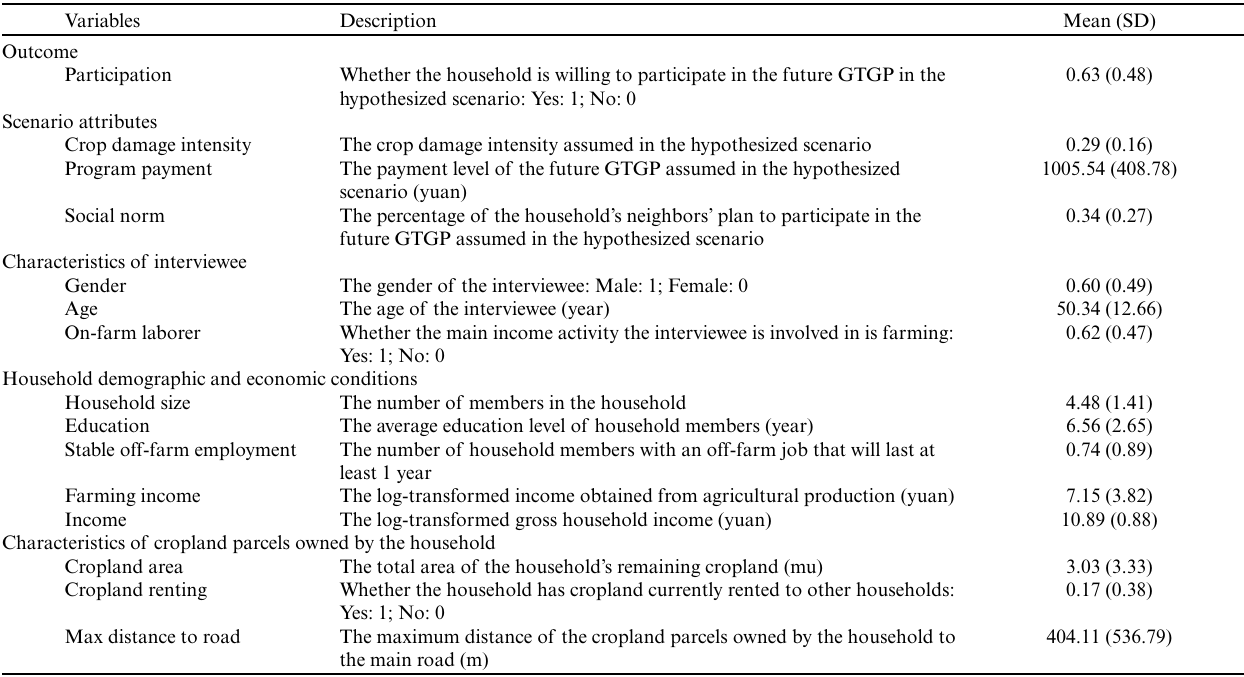
Table 1 . Descriptive statistics of variables that were used to construct the stated choice model (GTGP: Grain to Green